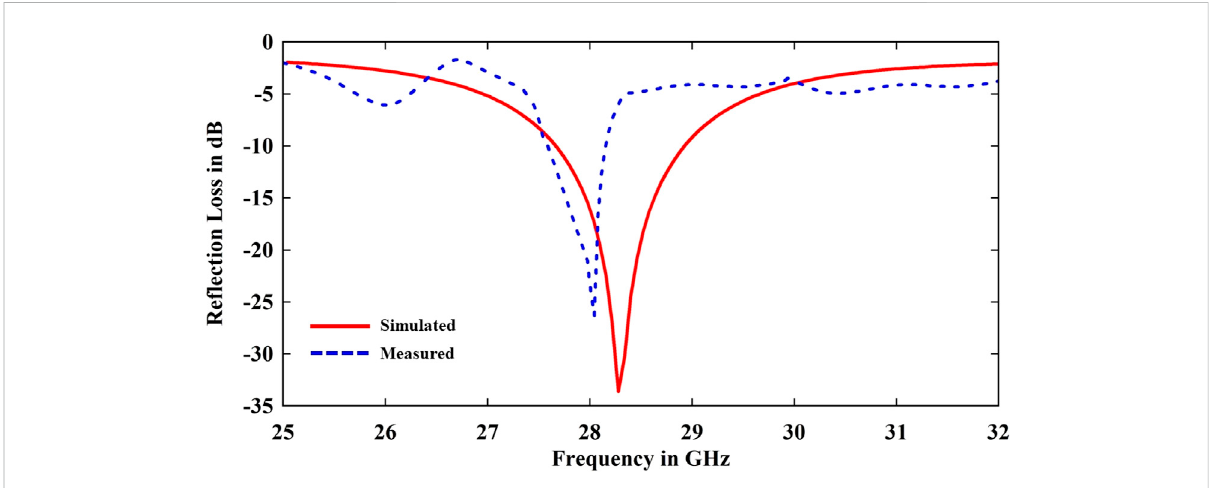
FIGURE 9 Simulated vs. Measured return loss.